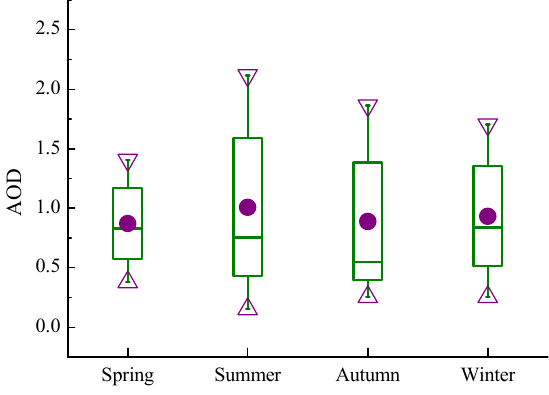
Figure 3. Seasonal statistics of AOD at 500 nm. The purple dot represents the AOD mean of the maximum and minimum in each season; the box is 25 and 75 percentiles; the triangles represent the maximum and the minimum, respectively, and the short horizontal line represents the seasonal averaged AOD value.